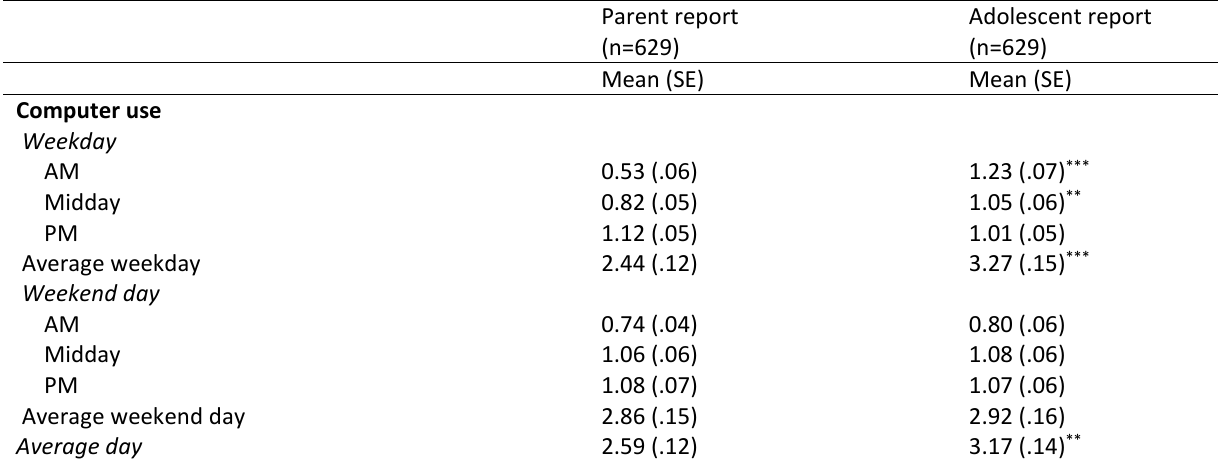
Table 2 . Weighted parent and adolescent reports of adolescents’ hours spent with television, video games, and com- puter on weekdays and weekends, by time of day.